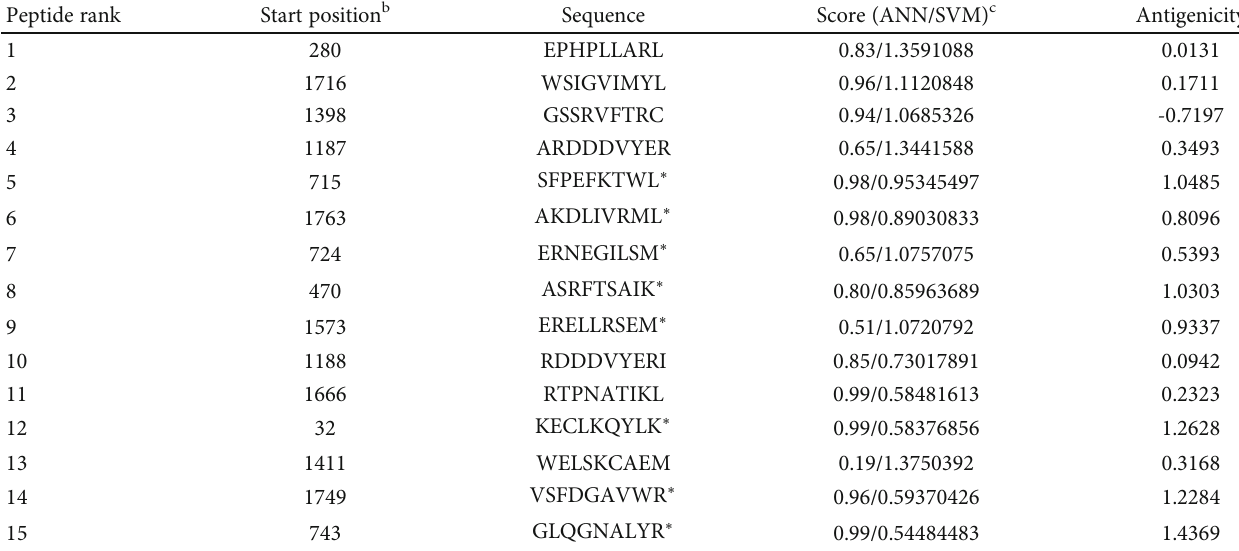
Table 7: Predicted CDPK7 epitopes by CTLpred a